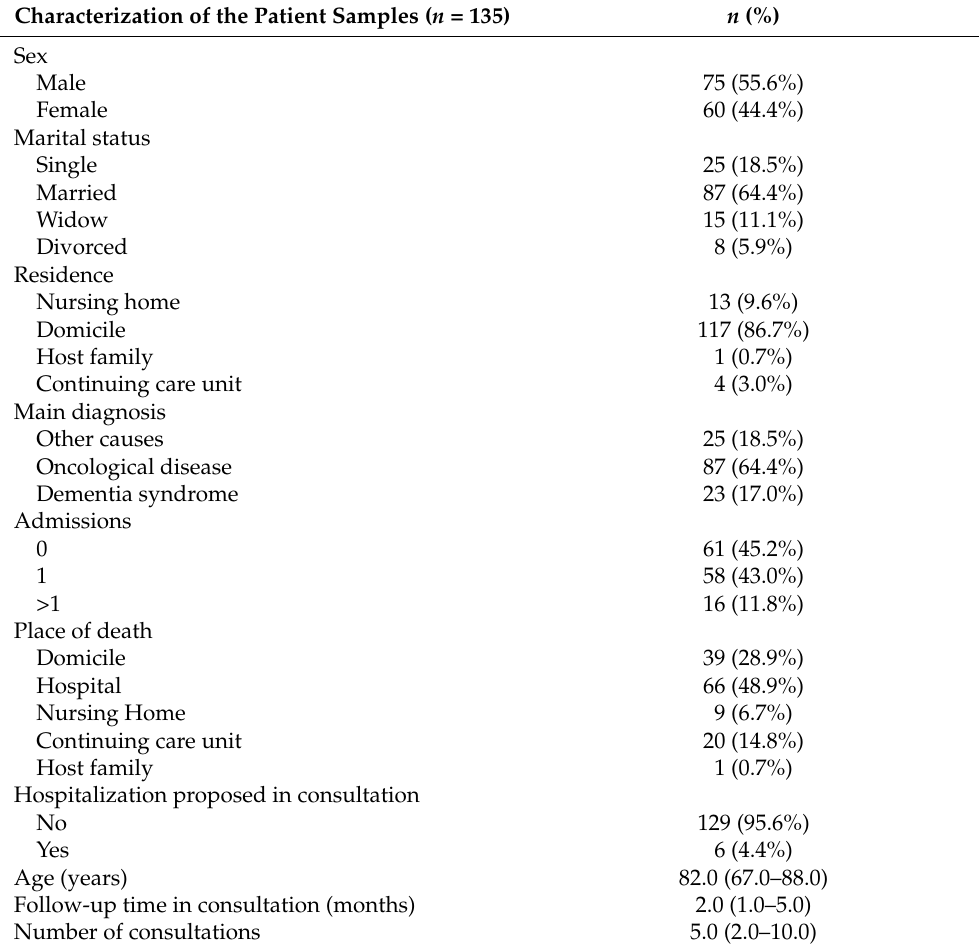
Table 1. Characterization of the patient